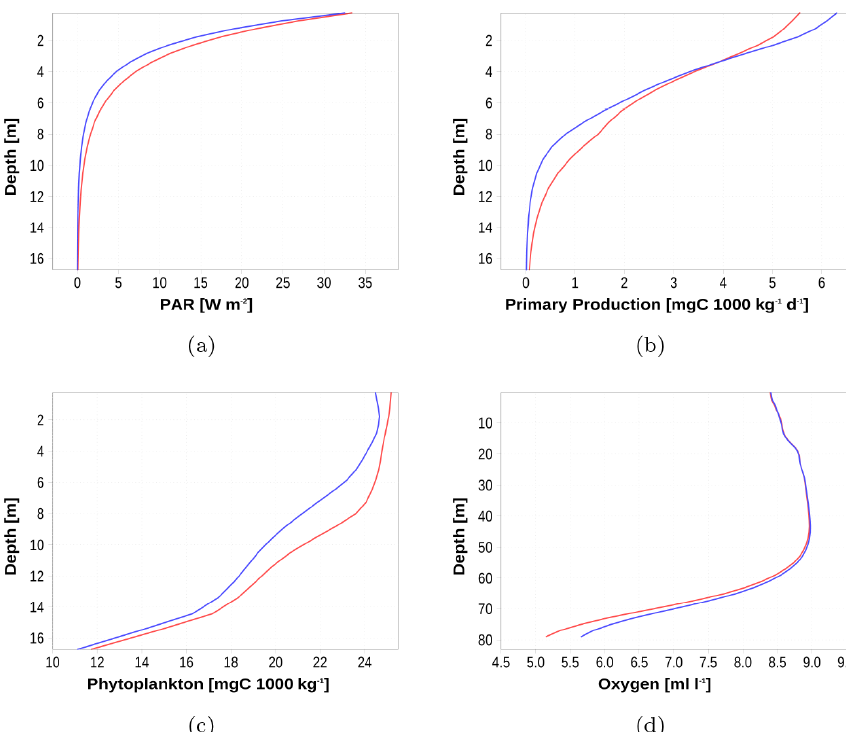
Figure 7. 2018 annual mean profiles at station 4 (Fig. 6d). Blue curve shows data from the model with an explicit CDOM state variable, and the red curve is from the model with CDOM absorption estimates based on its relation to salinity. For oxygen (d) , we show the whole water